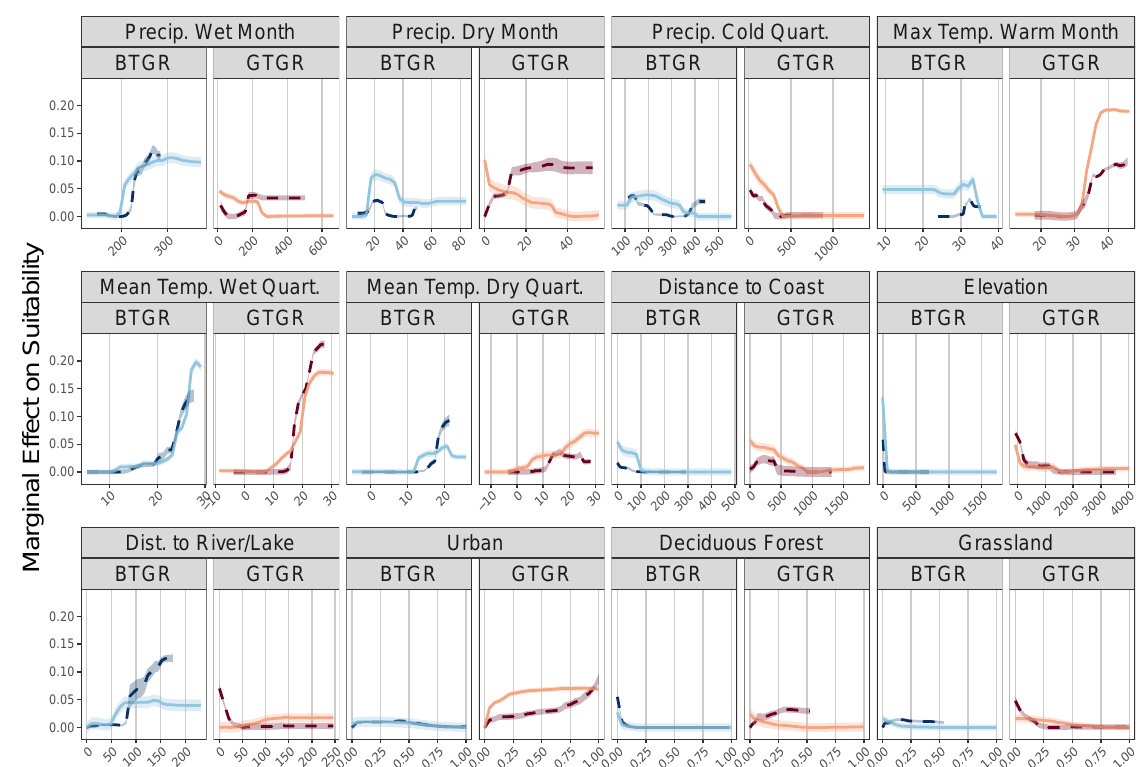
Figure 5 – Partial dependence curves for the 12 most important environmental predictors across all boat-tailed grackle (BTGR) and great-tailed grackle (GTGR) models. The curves represent how changing each environmental predictor changes the encounter rate for the modeled species. The historic models are represented by the darker dashed lines and the current models are represented by the lighter solid lines. Shaded regions indicate one standard deviation. The differences between the historic and current models for each species present how realized niches of each species as predicted by our models have